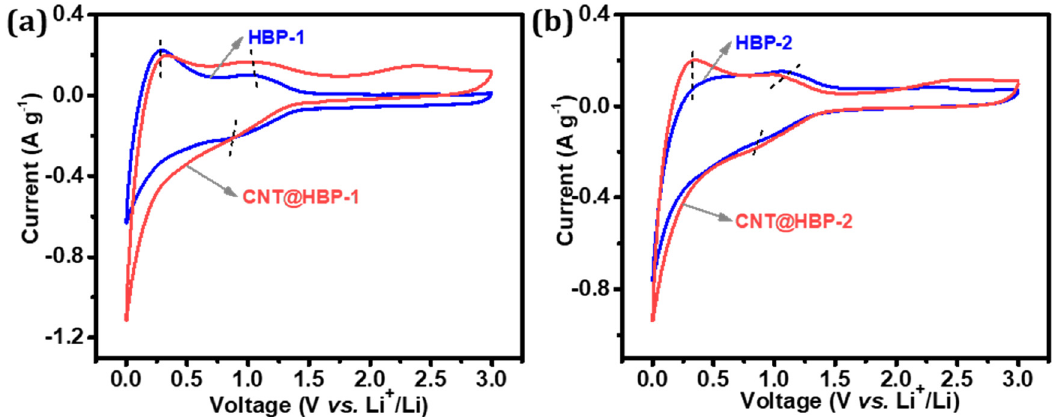
Figure 6: Stable CV curves of ( a ) HBP - 1 and CNT@HBP - 1 and ( b ) HBP - 2 and CNT@HBP - 2 at a scan rate of 0.5 mV s − 1 in the third